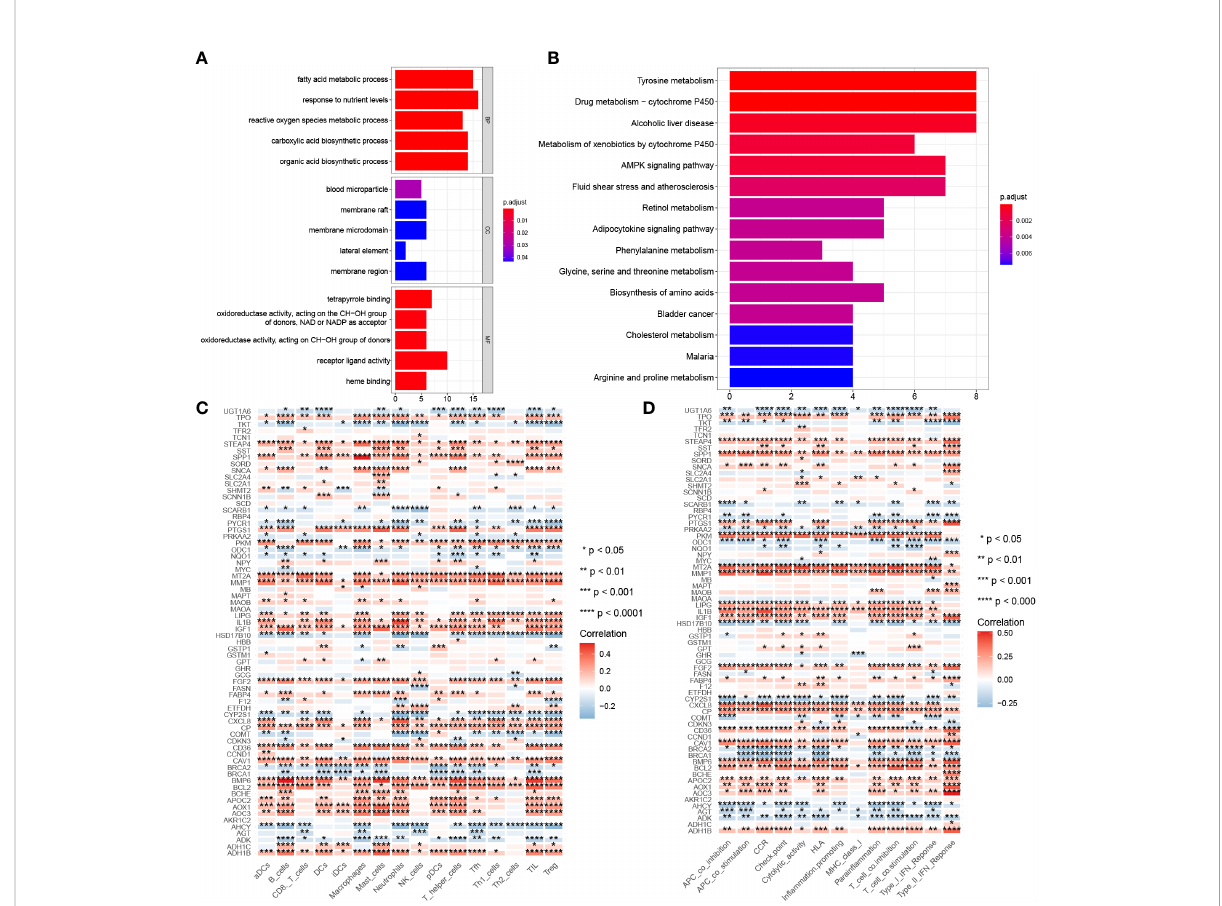
FIGURE 4 Gene function and correlation with immunity. (A) GO analysis of 68 differentially expressed CMRGs. (B) KEGG analysis of 68 differentially expressed CMRGs. (C) Correlation between 68 differentially expressed CMRGs and immune cell in fi ltration in tumors. (D) Correlation between 68 differentially expressed CMRGs and immune function in tumors. GO, Gene Ontology; BP, biological process; CC, cellular component; MF, molecular function; KEGG, Kyoto Encyclopedia of Genes and Genomes. 0 ≤ ****<0 .0001 ≤ *** < 0.001 ≤ ** < 0.01 ≤ * < 0.05 ≤ . <